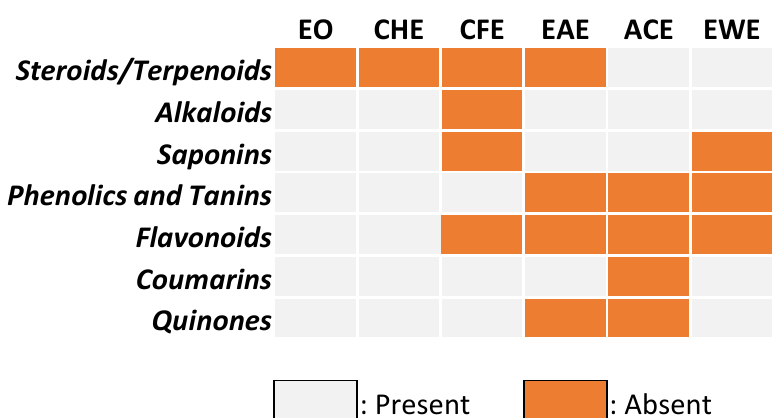
Figure 2. Qualitative phytochemical screening of C. aurantium peel extracts.